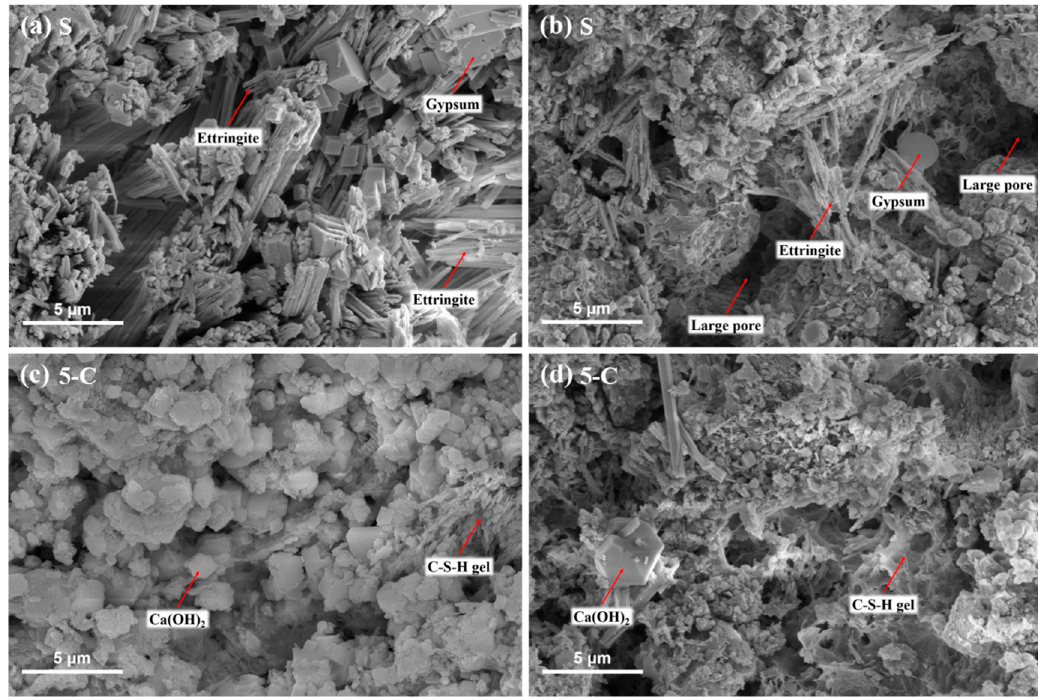
Figure 14. SEM micrographs of specimens under sulfate attack.